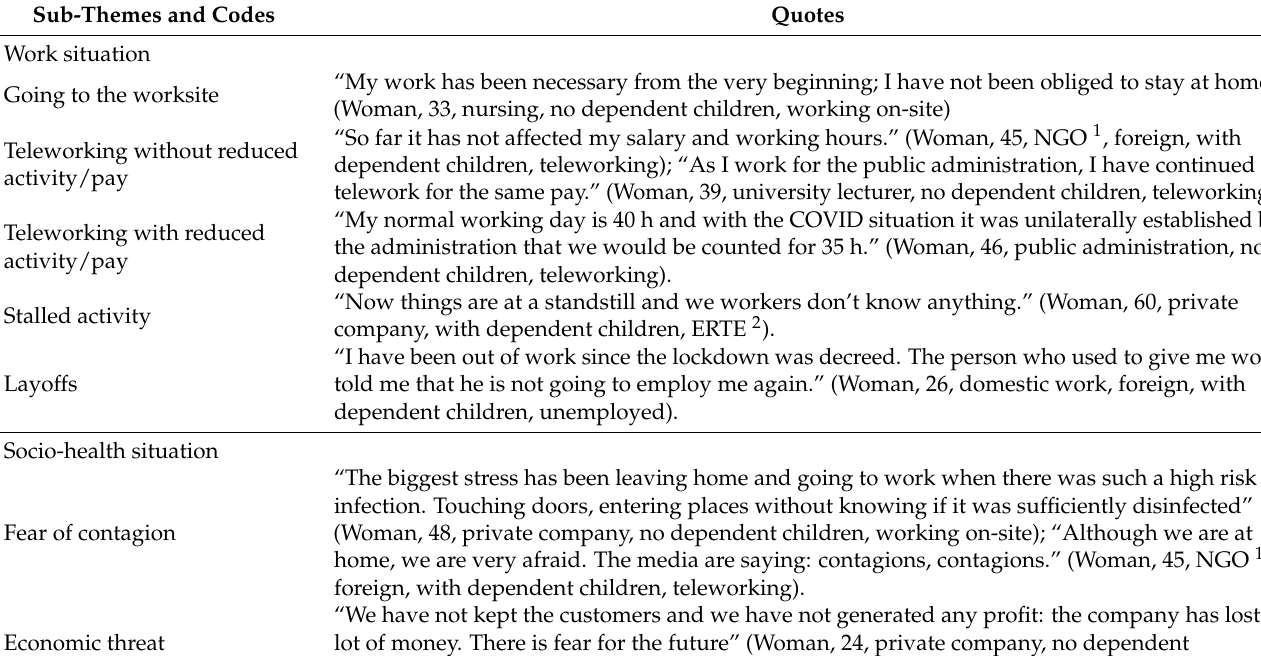
Table 1. Theme 1 developed from thematic analysis in Study 1: “work and socio-health situation”. Sub-Themes and